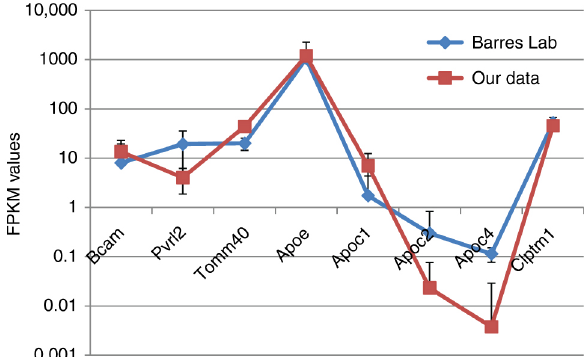
Figure 1: Assessment of 8 consequent genes expression by FPKM values in two projects. Average FPKM values, across 45 samples and 7 cell lines, from our data and previous data from Barres Lab [4], correspondingly, are presented for eight genes. Bars represent standard deviation.